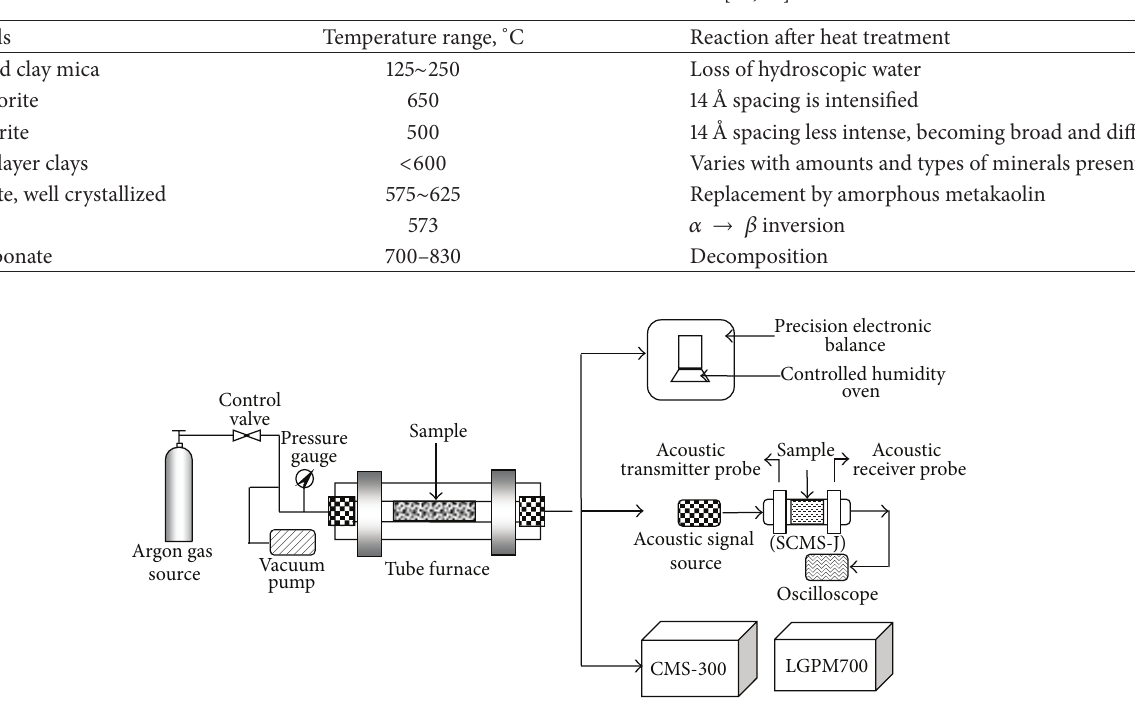
Table 3: Heats of reaction for several minerals [34, 35].